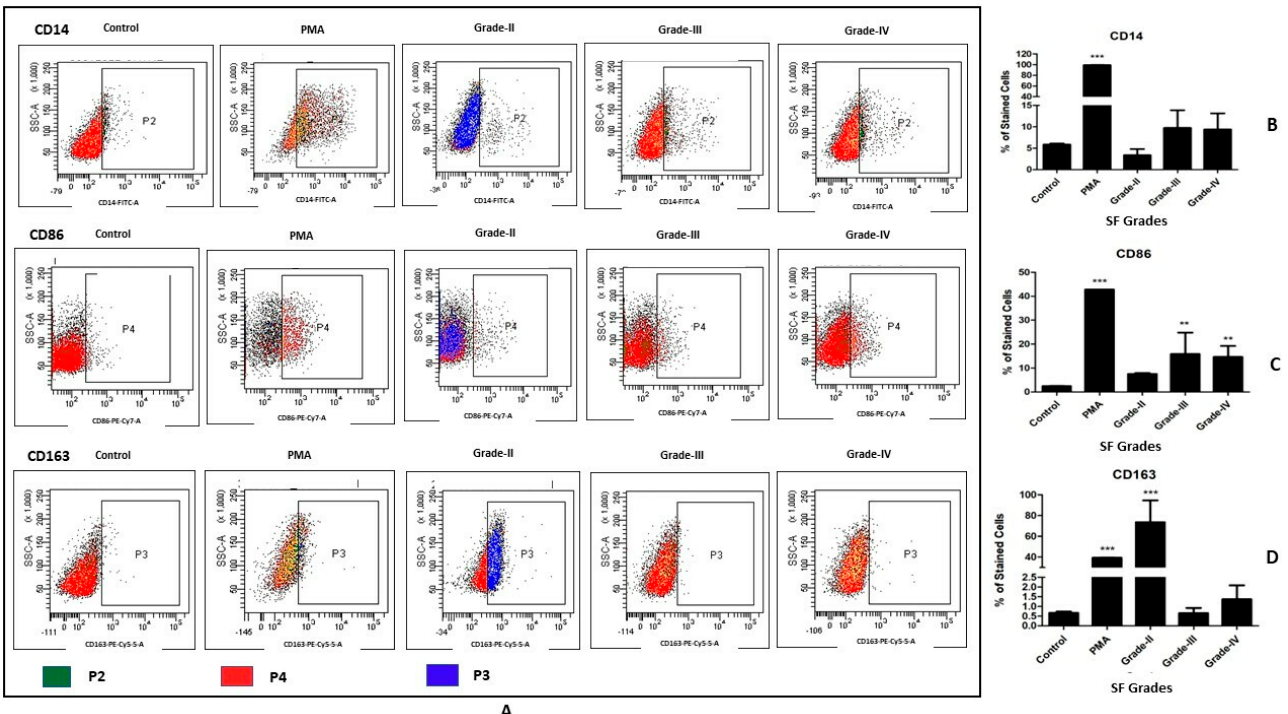
Figure 2. In vitro cell differentiation assay on U937 cells. U937 cells were induced using SF of KL grade II, III and IV for 48 h and status of the newly differentiated cells were evaluated using macrophage-specific cell surface markers—CD14, CD86, and CD163; ( A ) representative scatterplots of macrophages and their subtypes; CD14 is a marker for M0 macrophages, while CD86 and CD163 represent M1 and M2 subtype, respectively; the gating strategy of cell population selection was based on isotype control; ( B – D ) demonstrate a grade-wise staining trend for CD14+, CD86+ and CD163+ cells, respectively; for these graphs, we used the average percentage of each cell surface marker calculated from three sets of experiment, wherein four SF samples of each KL grade were used in each set of experiment (n = 12); the experiment was performed in quadruplet and repeated for three times. * p < 0.05, ** p < 0.01, *** p < 0.001, as compared to control.